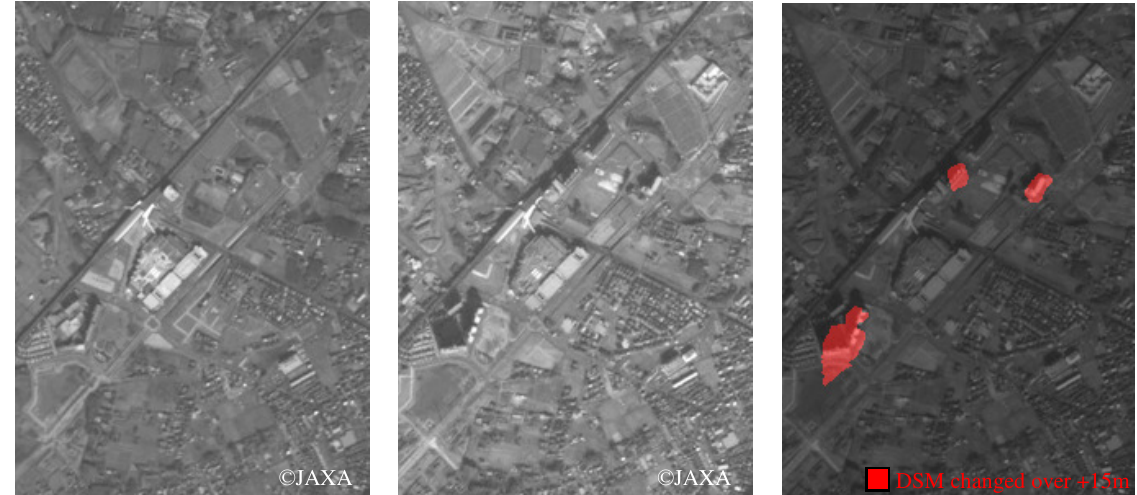
DSM changed over